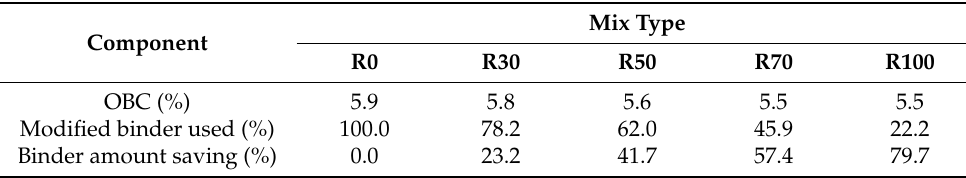
Table 4. Percentage of OBC and the amount of binder.